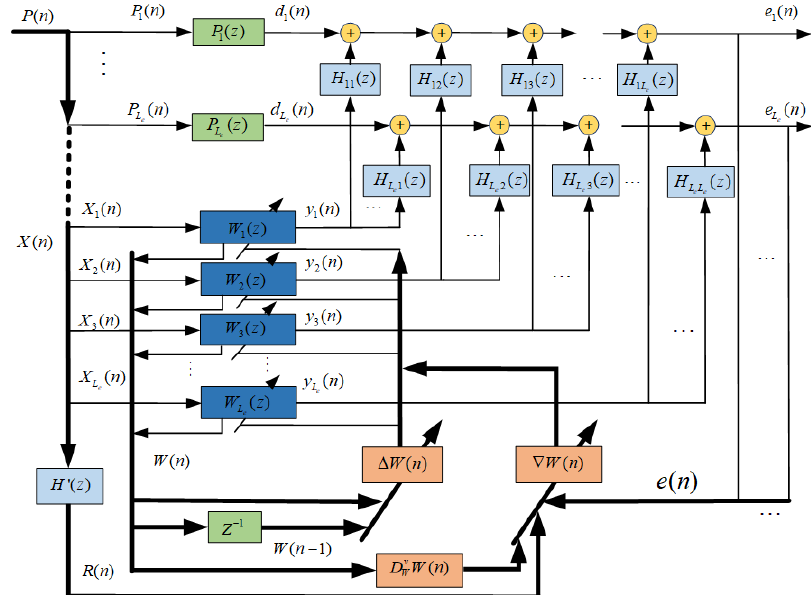
Figure 2. Block diagram of multi-channel fractional-order ANC algorithm. For the whole system, there are